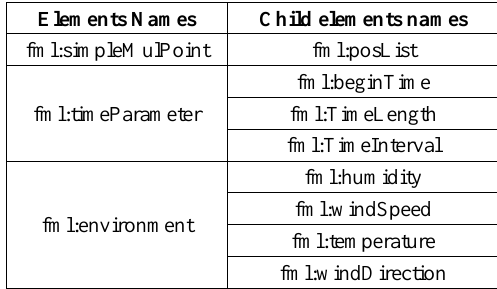
Table 1. The main elements of input